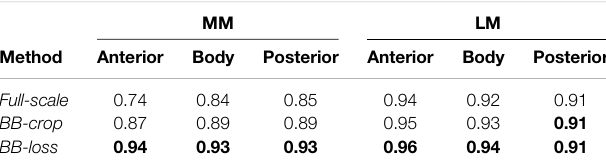
TABLE 2 | ROC AUC results for medial menisci (MM) and lateral menisci (LM) in DESS MRI data.